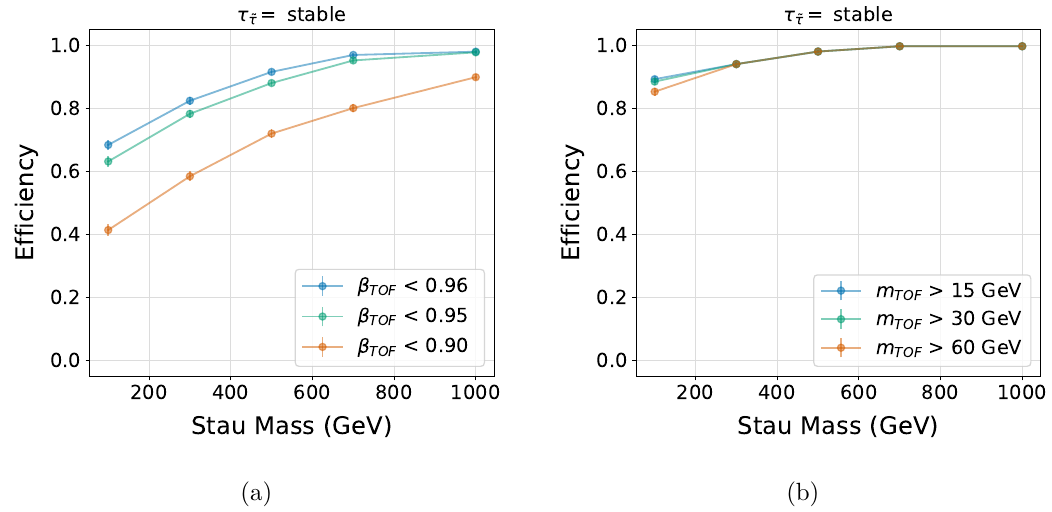
Figure 34. Efficiency with respect to various requirements on measured track β (a) and measured mass